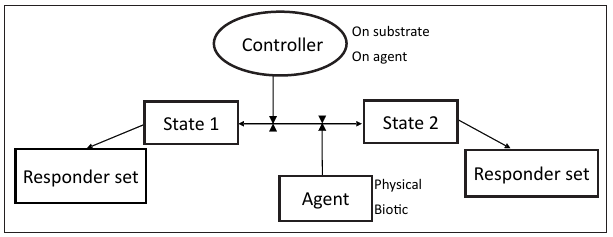
FIGURE 1: Pickett et al .’s (2003) framework for understanding the generation of and responses to heterogeneity, used during the process of unpacking concerns in Science–Management Forum meetings.